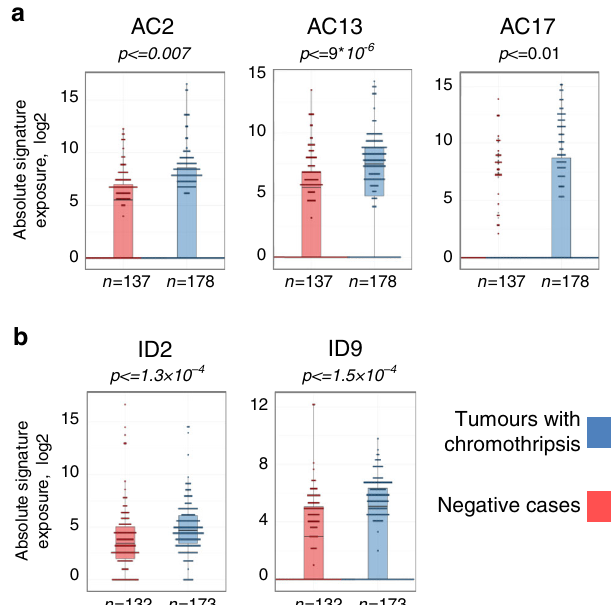
Fig. 7 Chromothripsis is linked with speci fi c mutational signatures. Representative examples of base substitution signatures ( a ) and indel signatures ( b ) in chromothripsis-positive versus chromothripsis-negative tumours across all entities. Signi fi cance was tested using Wilcoxon tests (two-sided). Family-wise correction of p values was performed according to Bonferroni. Supplementary Fig. 7 shows representative examples of mutational signatures in speci fi c tumour entities. Bars show median values, dots show individual values and whiskers show maximum and